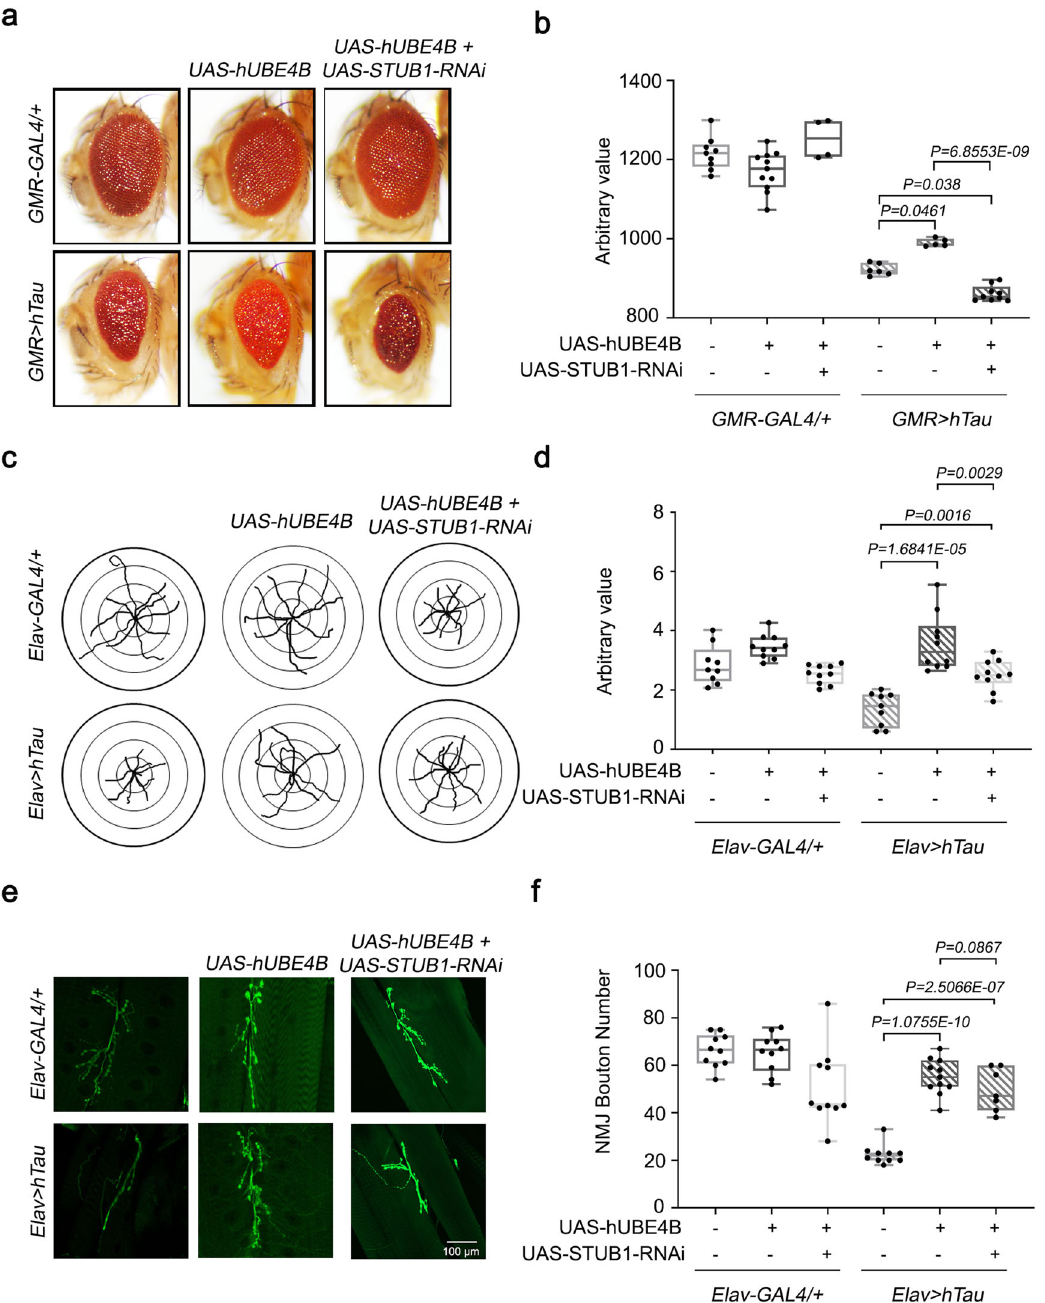
Fig. 5 STUB1 knockdown reduces UBE4B -mediated alleviated hTau phenotypes in Drosophila . a , b Eye-speci fi c knockdown of Drosophila STUB1 signi fi cantly reduced eye size relative to GMR > hTau + hUBE4B fl ies. N = 5 biologically independent experiments. In the box plots the whiskers